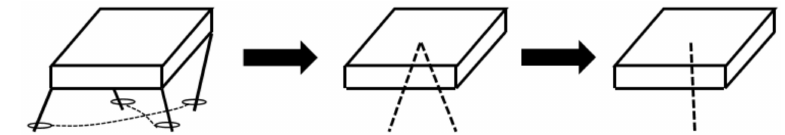
Figure 3. Virtual leg equivalent model of the quadruped